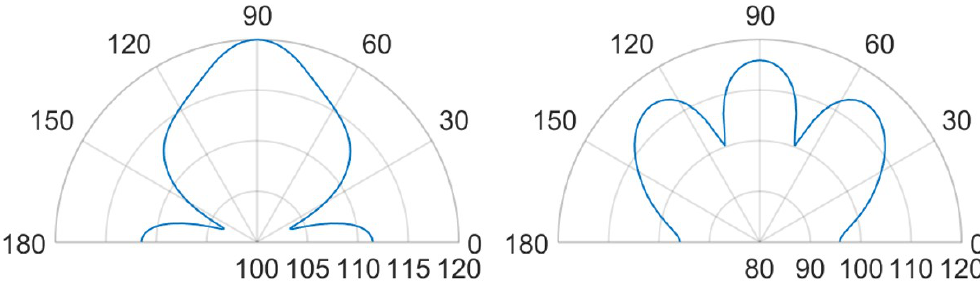
Figure 26. SPL polar plot (dB) at the performing fundamental frequency of 93.0 kHz (3 V bias), at 3.5 cm in the y(90 ◦ )–z(0 ◦ ) plane: (d) ( eft ), (e) ( right